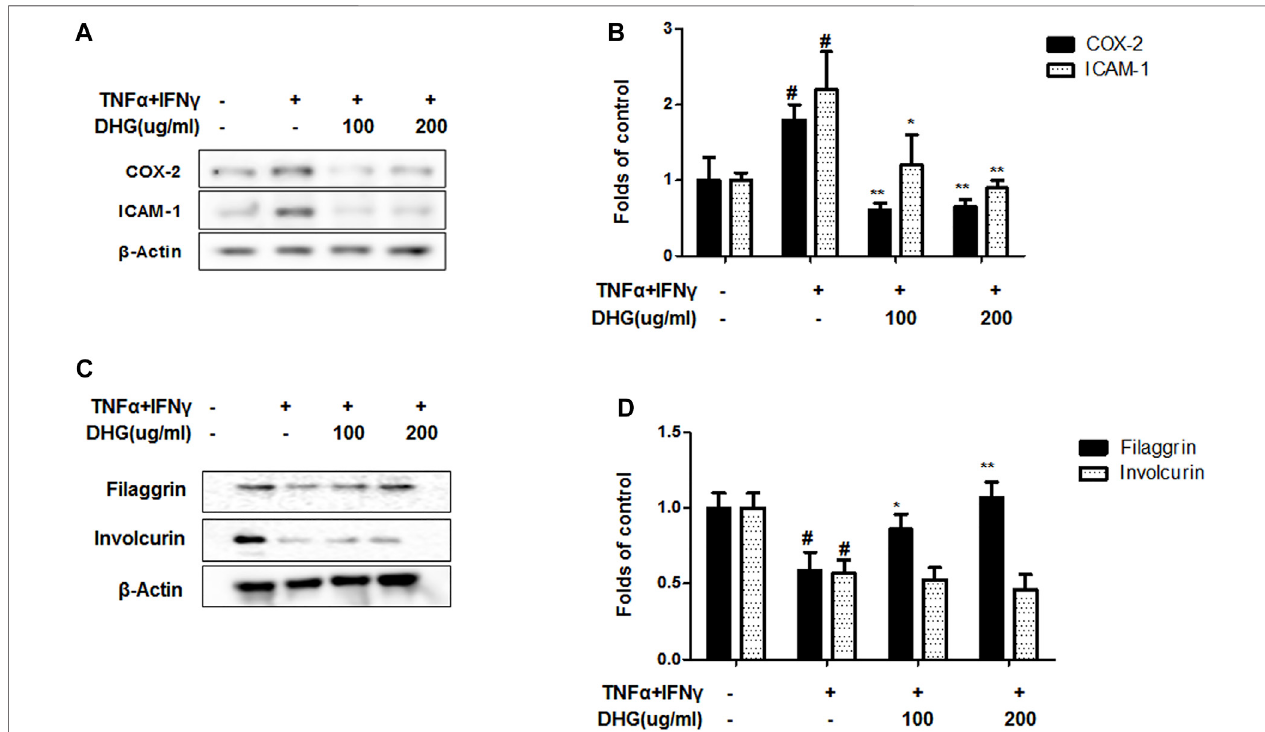
FIGURE 8 | The effects of DHG on expression of COX-2/ICAM-1 (A,B) and Filaggrin/Involcurin (C,D) in TNF- α /IFN- γ – induced HaCaT cells. The expression of ICAM-1, COX-2, Filaggrin and Involcurin were measured by using cell lysis. The cells were pretreated with the indicated concentrations of DHG for 3 h and then stimulated with TNF- α /IFN- γ (each 10 ng/ml) for 24 h. Data are represented as mean ± SD of three independent experiments. *P < 0.05, **P < 0.01. compared with the TNF- α /IFN- γ -treated group.